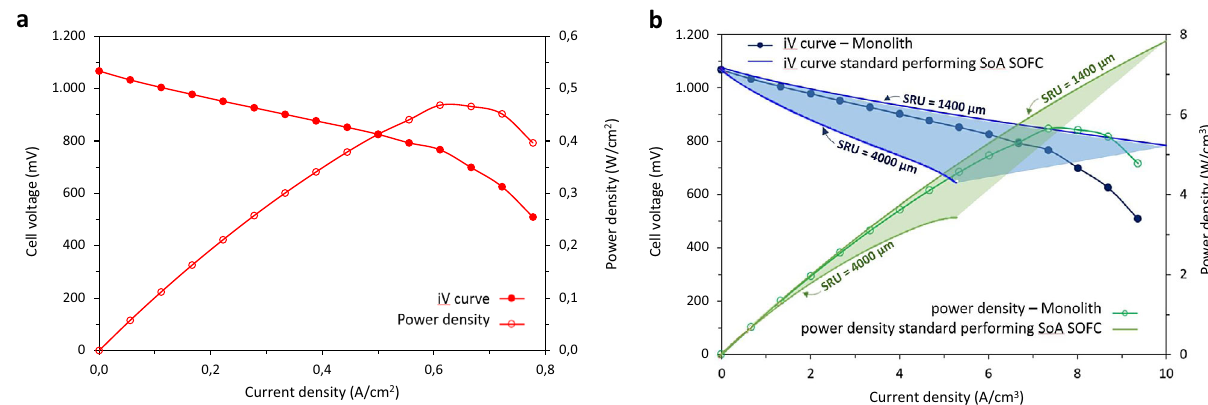
Fig. 4 Electrochemical performance and comparison with the SoA SOFCs. a i – V curve (full symbol) and power density (empty symbol) of SRU monolith cell with an active cell area of ∼ 18 cm 2 measured at 780 °C, dry H 2 (25 l/h) to the fuel electrode, and O 2 to the oxygen electrode. b , Comparison of initial electrochemical performance of the SRU monolith cell (blue full symbol) with that of SoA commercially available Ni/YSZ anode supported SOFCs (green empty symbol). The power density in terms of power per volume is based on a SRU height of 830 µ m for the monolith and in the range of 1400 – 4000 µ m for the SoA anode supported SOFCs